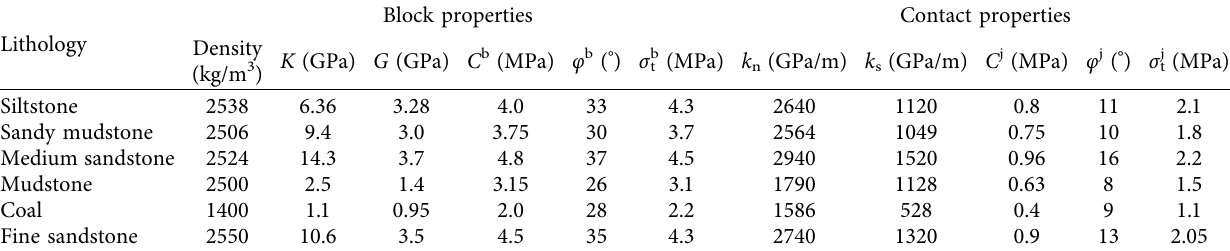
Table 1: The mechanical parameters of blocks and contacts.